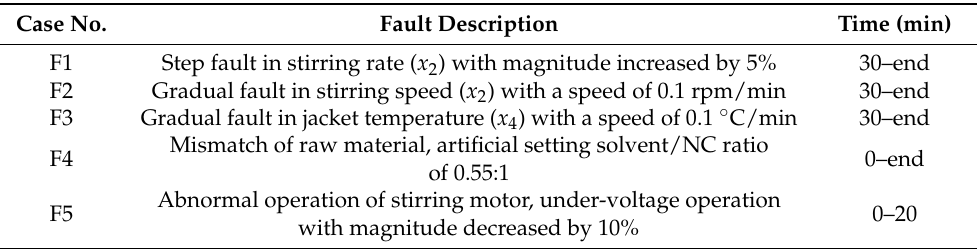
Table 3. List of faults introduced in the plasticizing process. Case